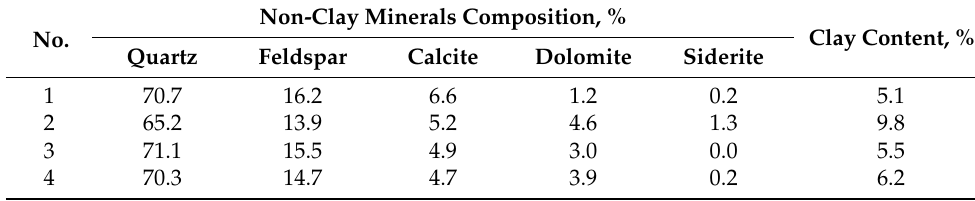
Table 2. Mineral compositions of rock